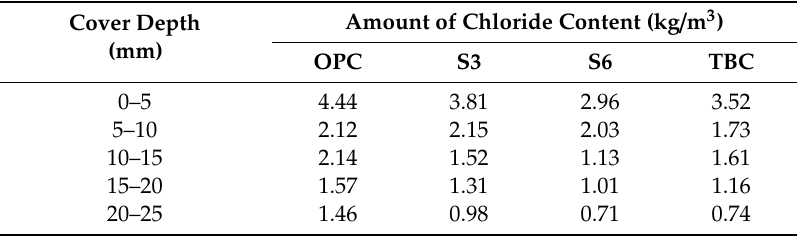
Table 8. Result of total chloride measurement.